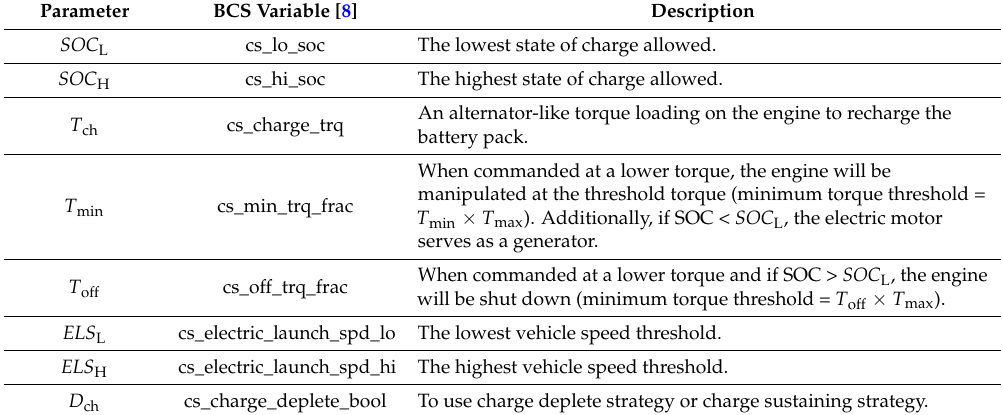
Table 1. Eight independent input parameters/variables for an electric assist control strategy (EACS). Parameter BCS Variable [8] Description